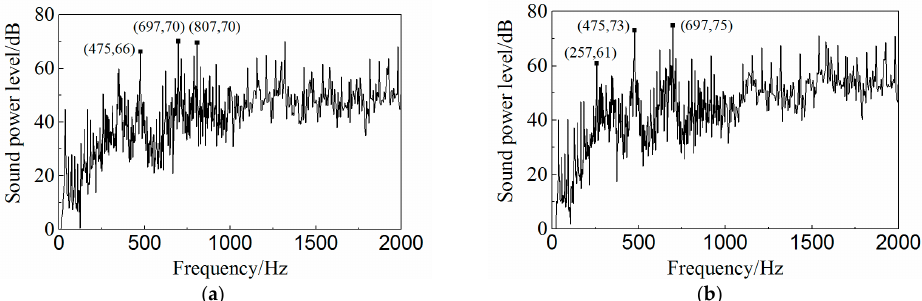
Figure 25. Predictions of noise of ( a ) the isotropic and ( b ) the orthotropic oil cooler covers.